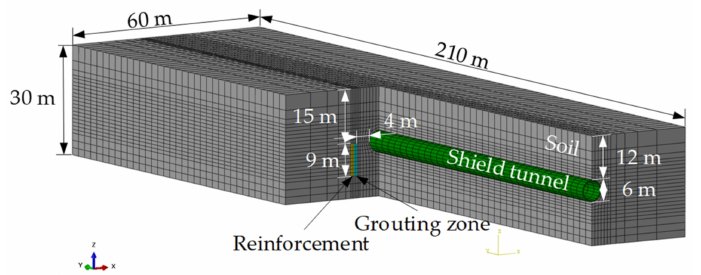
Figure 7. Finite element model for the parametric analysis.